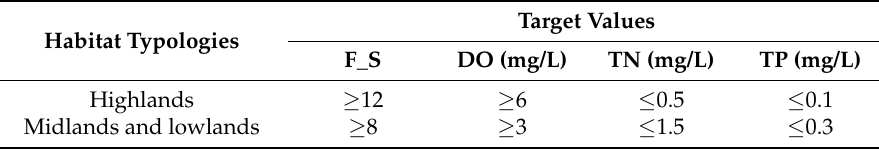
Table 3. Target values for ecological restoration in the Taizi